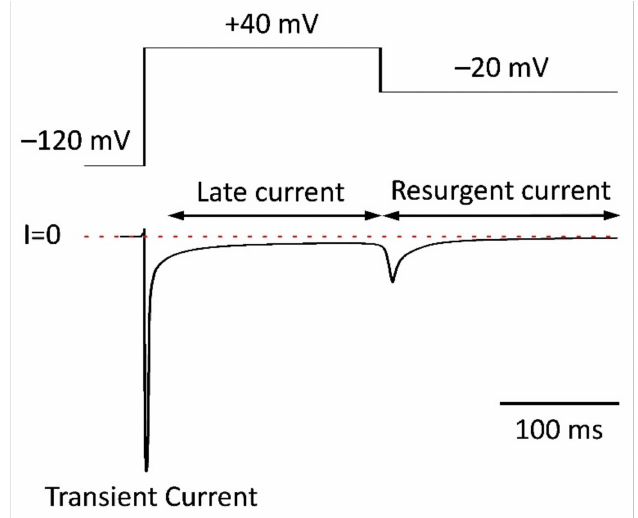
Figure 1. Schematic representation of the transient, late, and resurgent phases of sodium current during a rectangular command pulse. The transient phase is activated by brief depolarization, reaches the peak within a few milliseconds, and decays rapidly. The late phase follows the transient phase and terminated by the repolarizing step. The repolarization step activates the resurgent